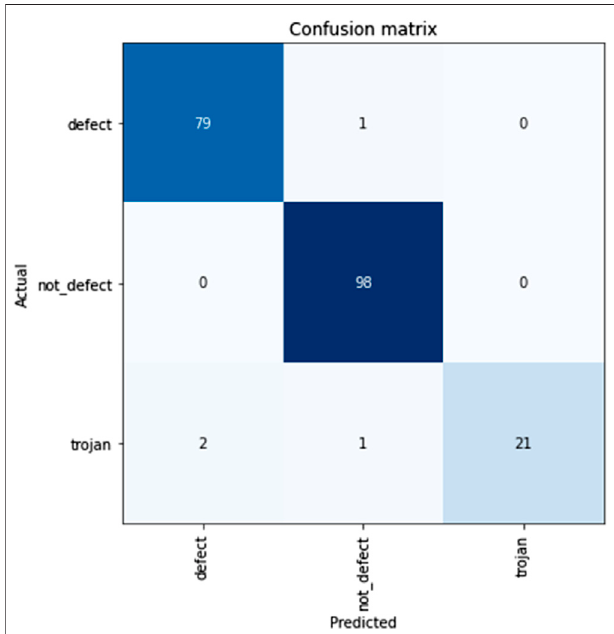
FIGURE3| ConfusionMatrixFortheTrojanclass, theTPvalueis21.FN value is 3, FP is 0, and TN is 177. The overall accuracy of the network is 98.51% with the True positive rate of the trojan class being at 87.5%.